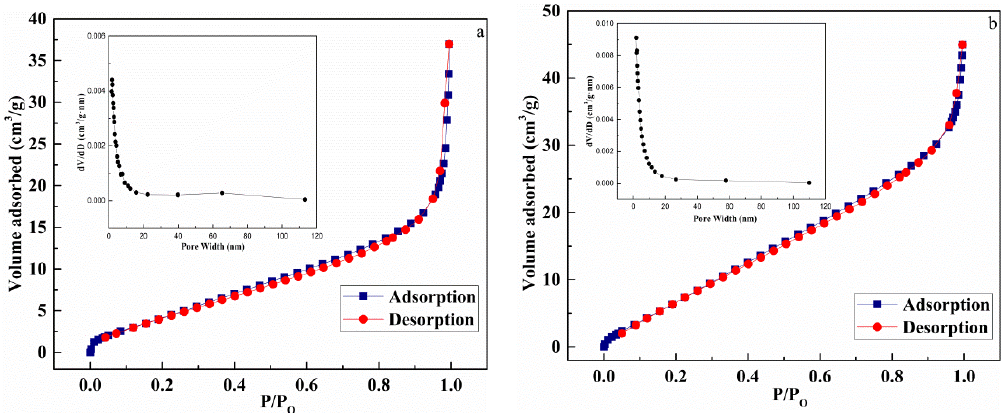
Figure 7. N 2 adsorption–desorption isotherms and pore size distributions of CuO ( a ) and Au 1.0 / CuO-300 ( b ).